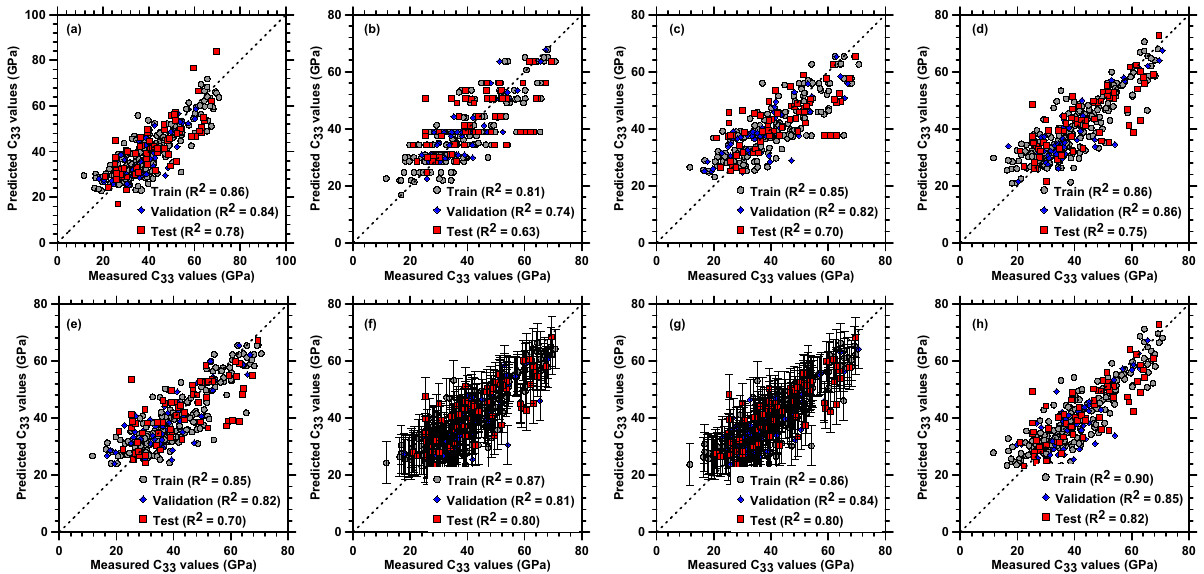
Figure 4. Comparison of the elastic constant C 33 predicted by ( a ) PR, ( b ) DT, ( c ) RF, ( d ) SVM (with RBF kernel), ( e ) k-NN, ( f ) GPR (with Matern kernel), ( g ) GPR (with RBF kernel) and ( h ) NN with measured values computed by MD simulation. The error bars shown for each value represent the standard deviation around the mean